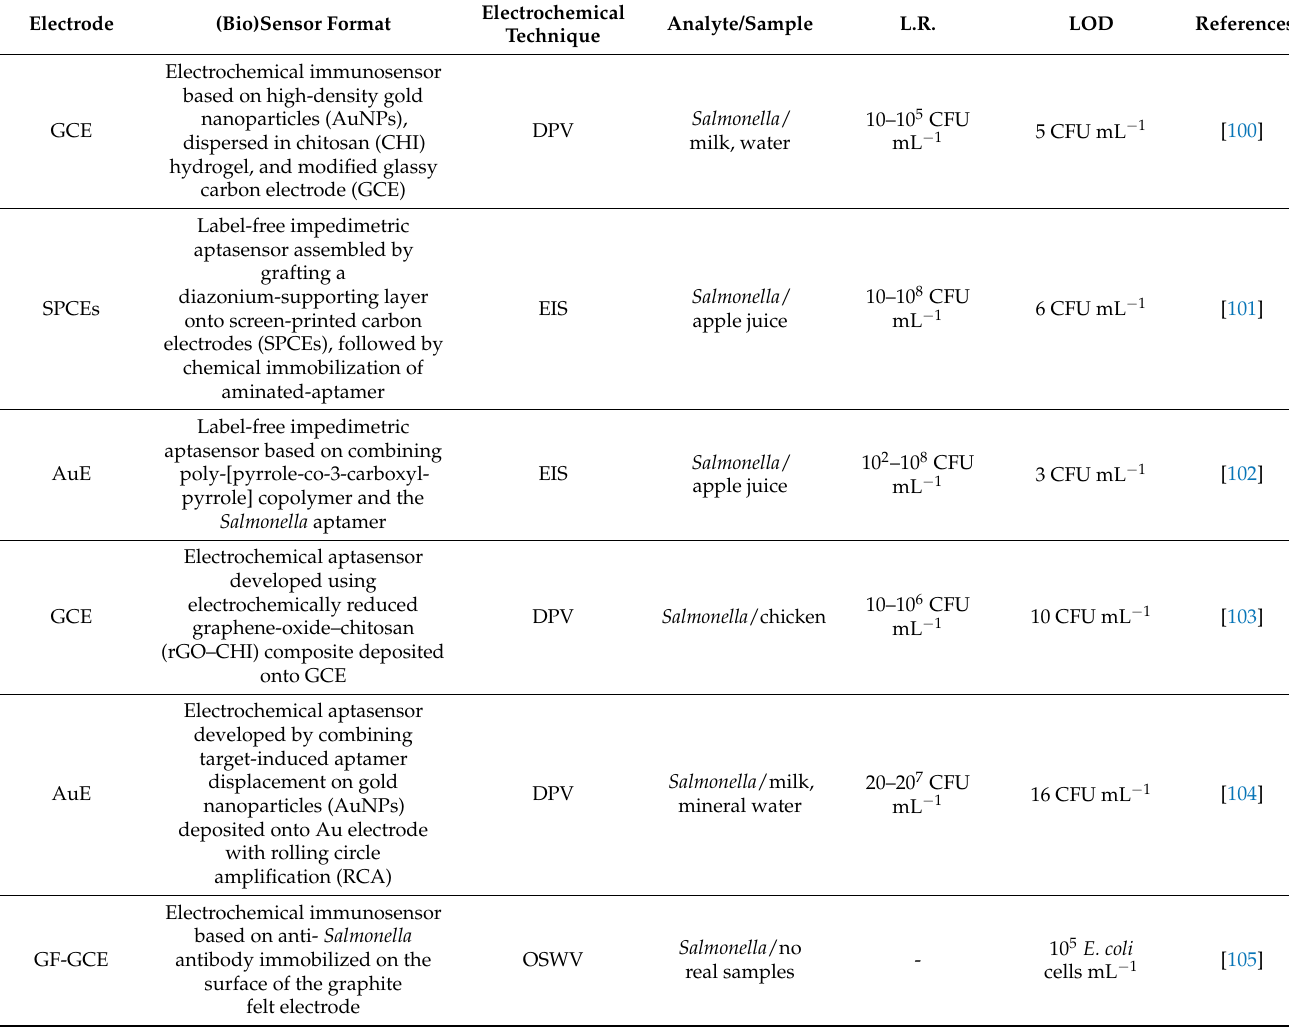
Table 2. Overview of recent electrochemical biosensors for pathogenic bacteria